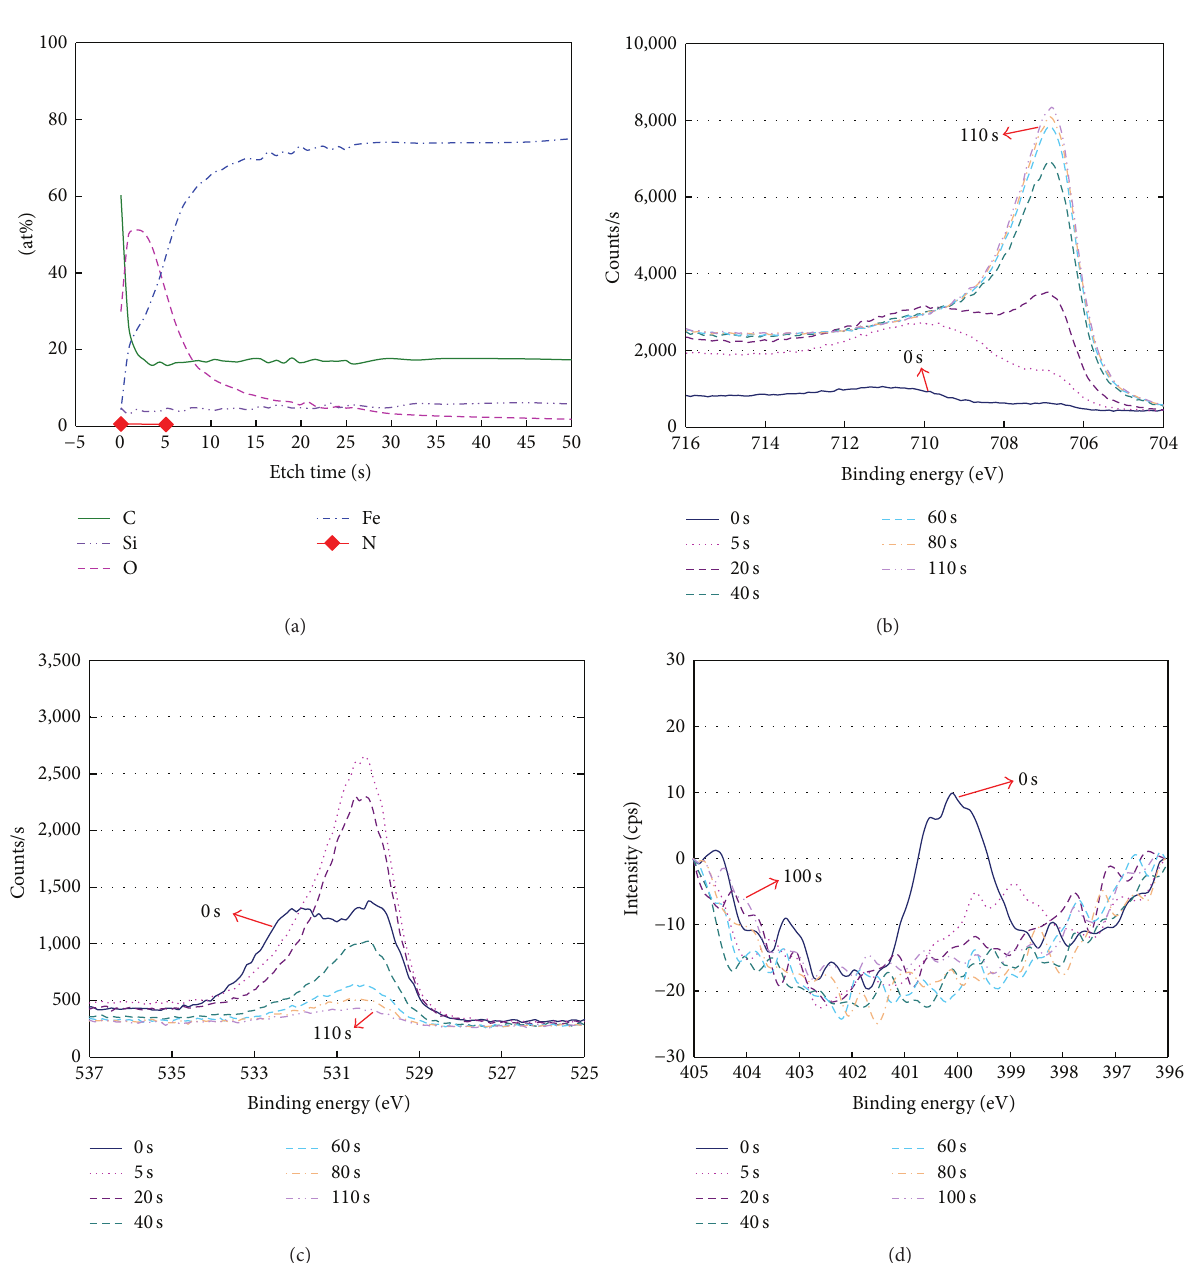
Figure 13: Depth profile by XPS on passive film of ductile cast iron passivated for 24 hours in simulated cooling water (100,000 ppm NaNO 2 ) at 25 ∘ C; (a) depth profile, (b) Fe 2 p detail scan, (c) O 1 s detail scan, and (d) N 1 s detail